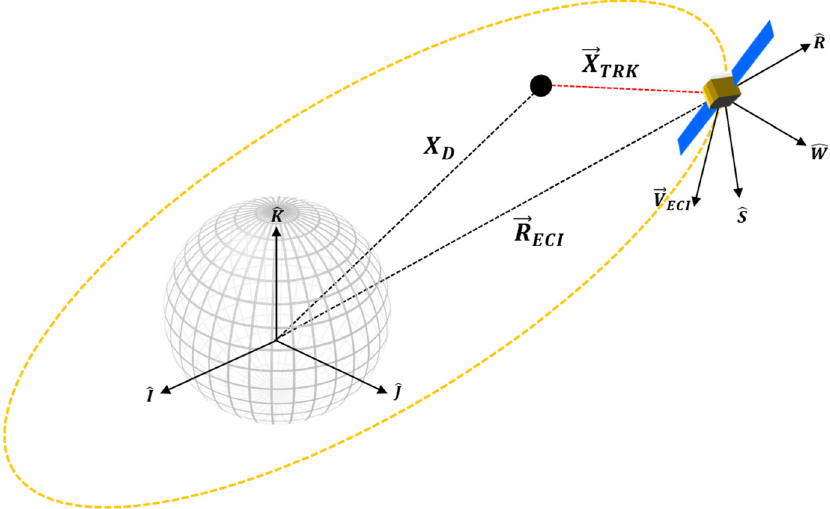
Figure 5. Reference geometry of the non-cooperative tracking and RSW coordinate system.